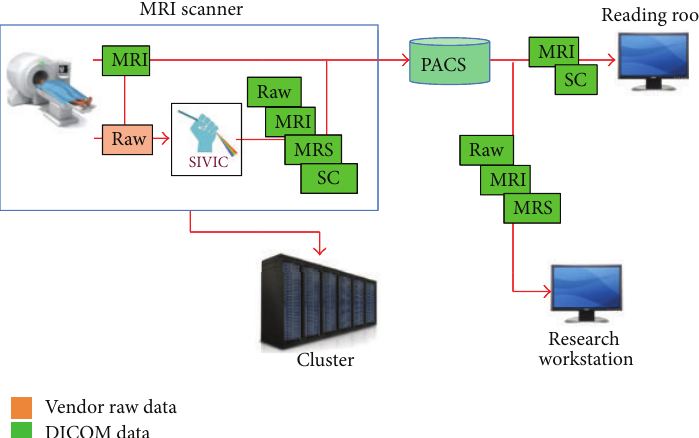
Figure 5: On-scanner MRSI workflow. SIVIC running on the scanner reads raw MRSI vendor data and anatomical DICOM MRI images. MRSI data is reconstructed and DICOM MRS, DICOM MRI metabolite maps, and DICOM secondary capture (SC) images are exported and sent to PACS. DICOM SC and DICOM MRI images are viewed in the reading room. DICOM MRI (anatomical and metabolite maps) and DICOM MRS images may be viewed on a research workstation running SIVIC or other DICOM applications. CPU intensive on-scanner reconstruction may require a computational cluster for real-time analysis during an exam. Figure 10. In this scenario, raw data are encapsulated in